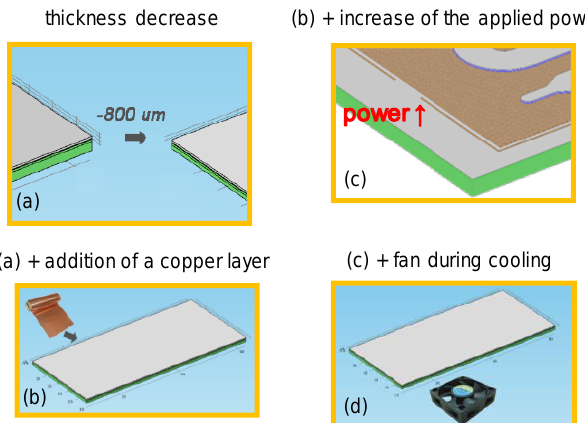
Figure 10. Graphical representations of the means to improve the performance of microPCR device: ( a ) decrease in thickness (case 2); ( b ) ( a ) with the addition of a copper layer between PCB and PMMA layers; ( c ) ( b ) with an increase of the applied power at the resistance (microheater); ( d ) ( c ) with cooling with a fan.